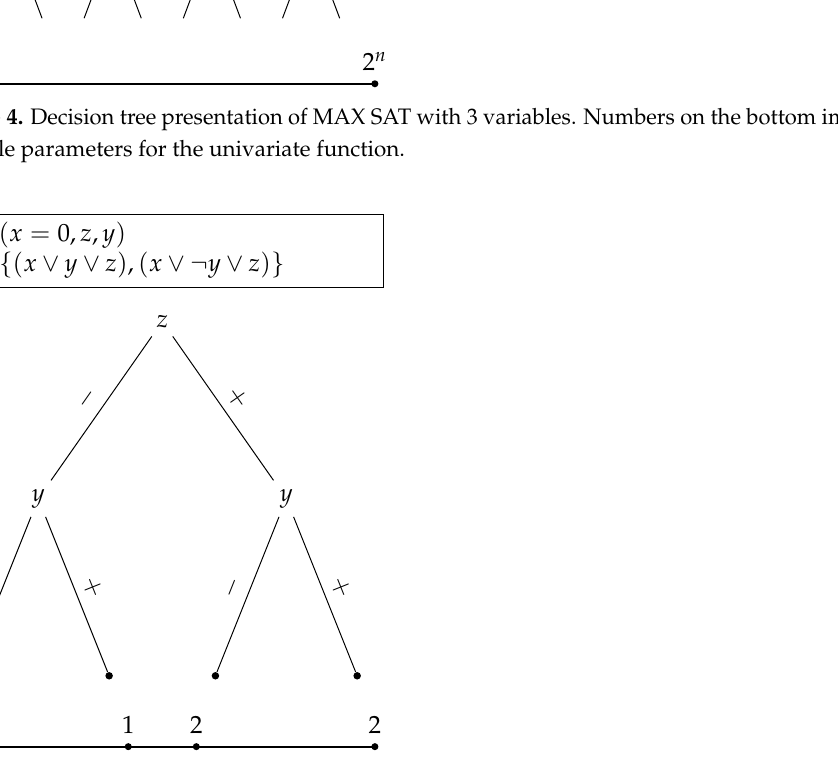
Figure 5. Geometric presentation of the MAX SAT problem with 3 variables where the order of the variables is ( x = 0, z , y ) (The numbers on the bottom imply the clauses are satisfied by the